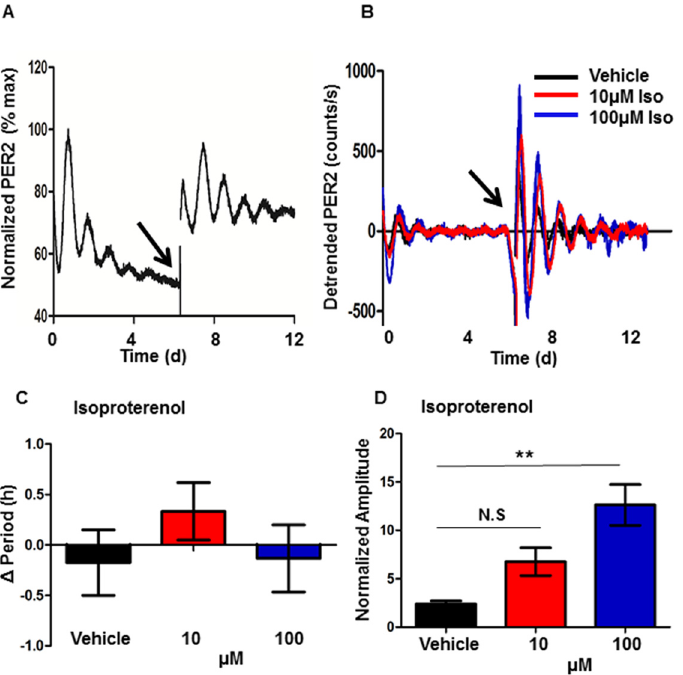
Fig 1. β -adrenergic receptor activation increases PER2::LUC rhythm amplitude in ventricle explants. (A-B) Neonatal ventricle slices were synchronized with serum, and PER2::LUC rhythms were recorded for 2 weeks. At 7 days, medium was exchanged for medium containing either drug or vehicle control (arrow). (A) Representative PER2::LUC oscillations are shown for a control slice, expressed as a percentage of maximum bioluminescence intensity. (B) Representative detrended PER2::LUC oscillations are shown for slices treated with either vehicle (black trace), 10 μ M isoproterenol (Iso) (red trace), or 100 μ M Iso (blue trace), expressed as bioluminescence intensity in counts/sec, with linear trend subtracted. The arrow shows the time of drug or vehicle treatment. Change in circadian rhythm period (C) and normalized amplitude (second peak, relative to initial serum treatment) (D) are shown for each drug treatment condition. Statistical analysis was by one-way ANOVA with a Bonferroni post hoc correction, ** p <